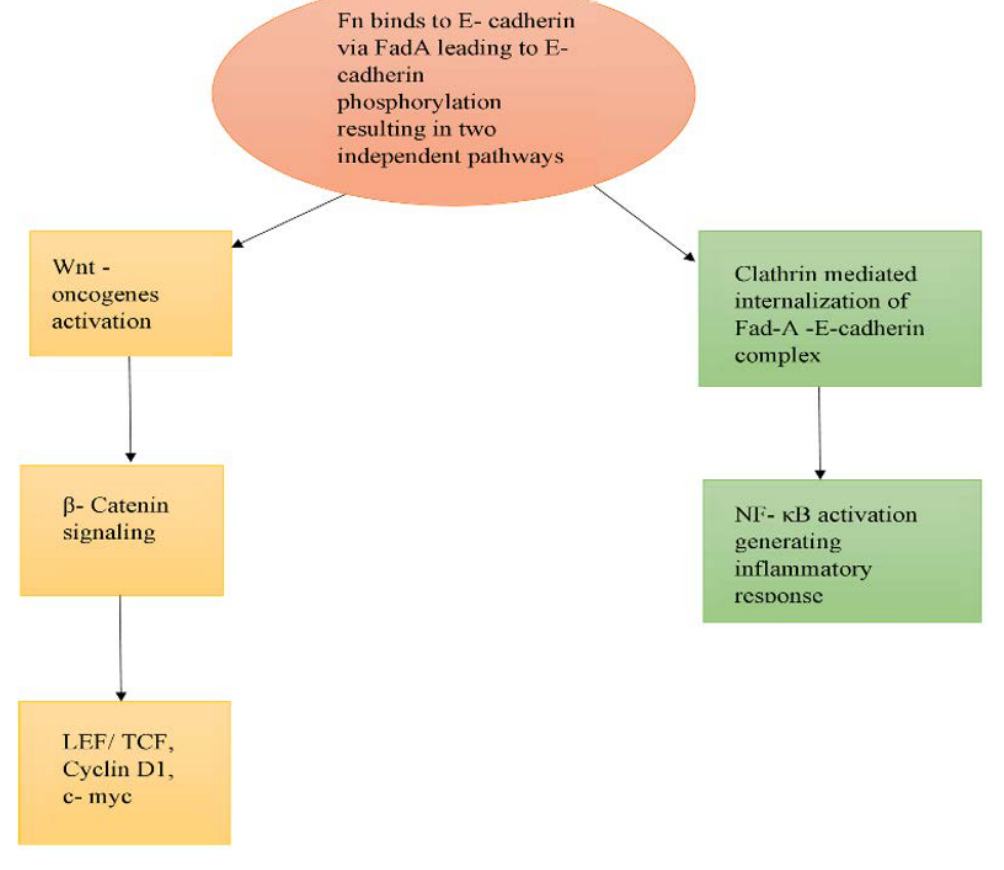
Figure 3. Pathway depicting FadA-mediated tumourigenesis by Fusobacterium nucleatum (Fn).